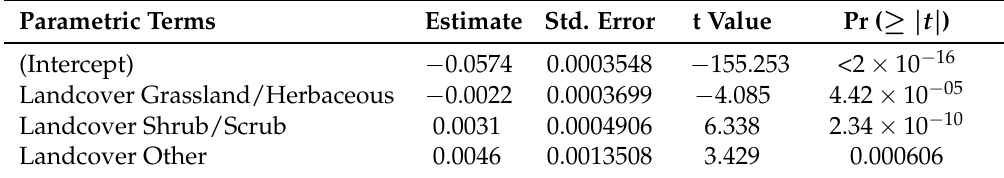
Table 3. Full function-on-scalar additive model. Estimation of the parametric terms. Parametric Terms Estimate Std. Error